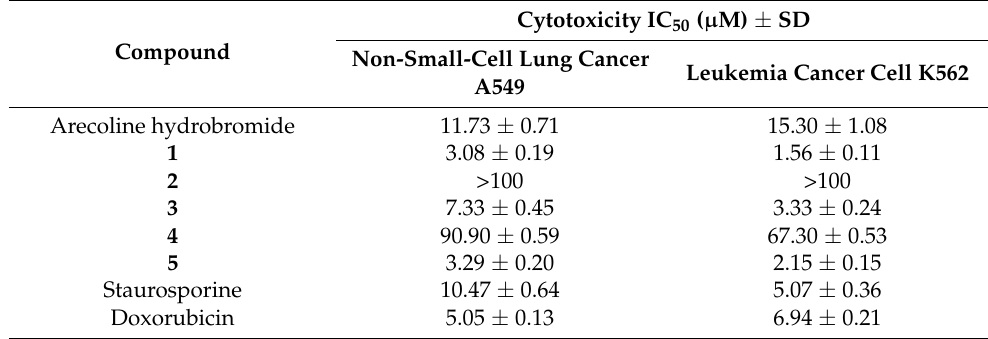
Table 1. In vitro cytotoxic activity (IC 50 ± SD) of arecoline hydrobromide and compounds 1 – 5 using non-small-cell lung cancer A549 and leukemia cancer cell K562.